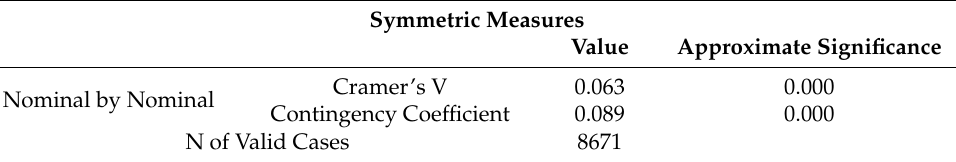
Table 12. Strength of dependence between variables. Source: own research.